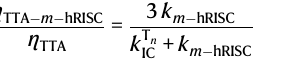
rate constant of hRISC process from T n to S m in the TTA- m -hRISC